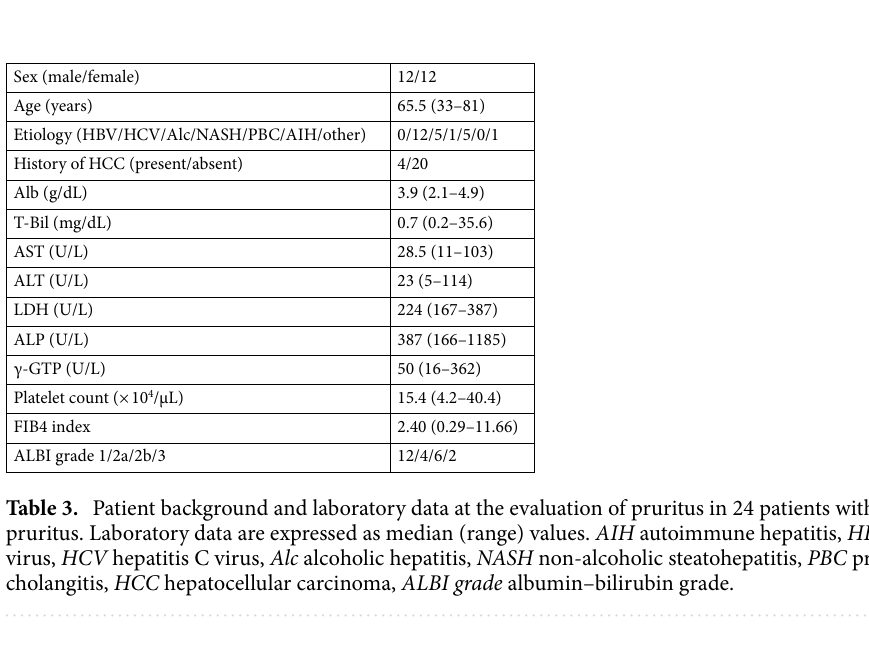
Table 2. Factors associated with pruritus in 450 patients with chronic liver disease.